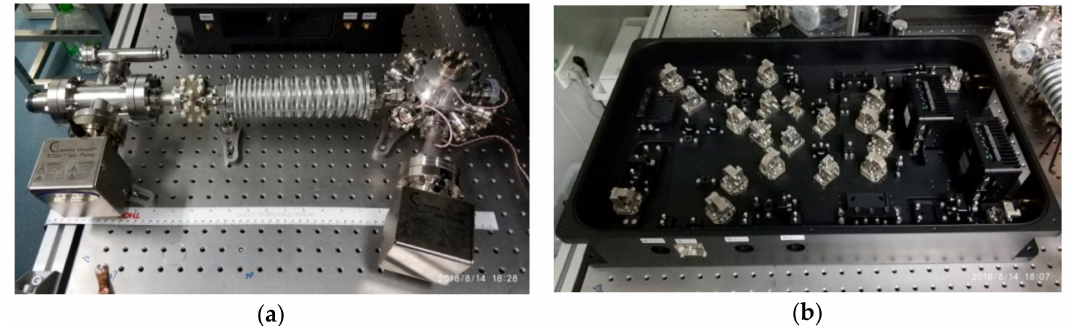
Figure 9. ( a ) Compact vacuum system of the 87 Sr optical lattice clock; ( b ) Modular 461-nm laser